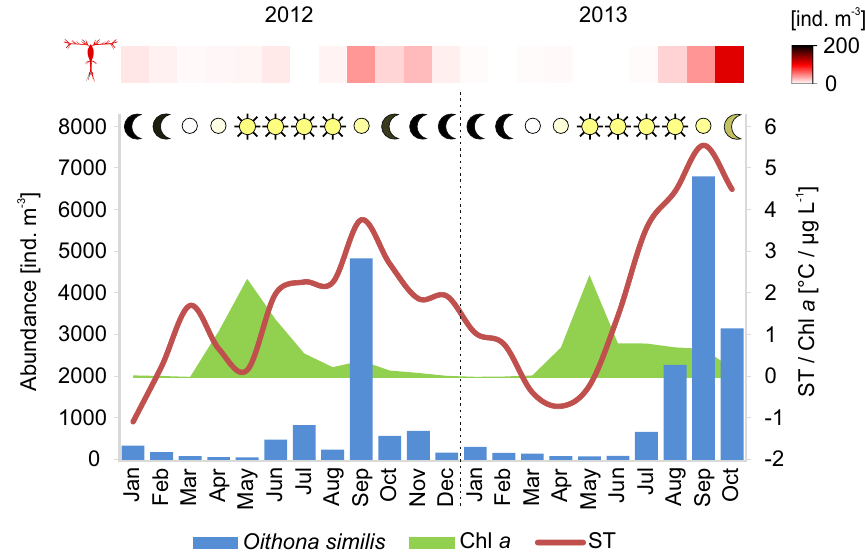
Figure 2. Oithona similis monthly mean abundance (ind. m -3 ) (left Y axis); monthly mean chlorophyll a concentration (Chl a , µg L -1 ) and seawater temperature (ST, °C) (right Y axis). The O . atlantica monthly mean abundance (ind. m -3 ) is represented by different shades of red (upper panel) measured at IsA station from 0–65 m and the monthly mean day-length (moon/sun icon) is expressed by different shades of yellow calculated using the NOAA solar